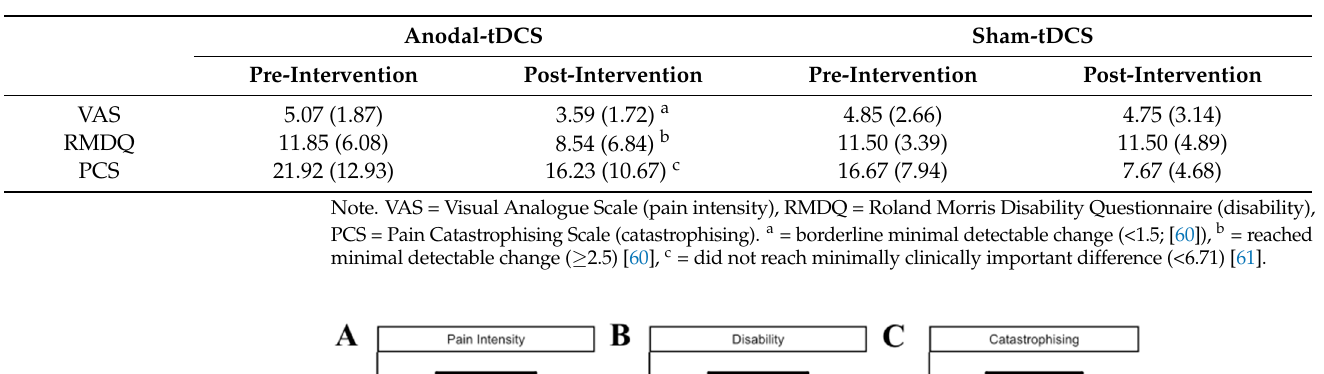
Table 2. Mean and standard deviation for Pain intensity, disability, and pain catastrophising pre- and post-intervention.